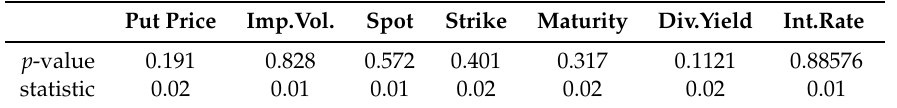
Table 4. Kolmogorov–Smirnov by